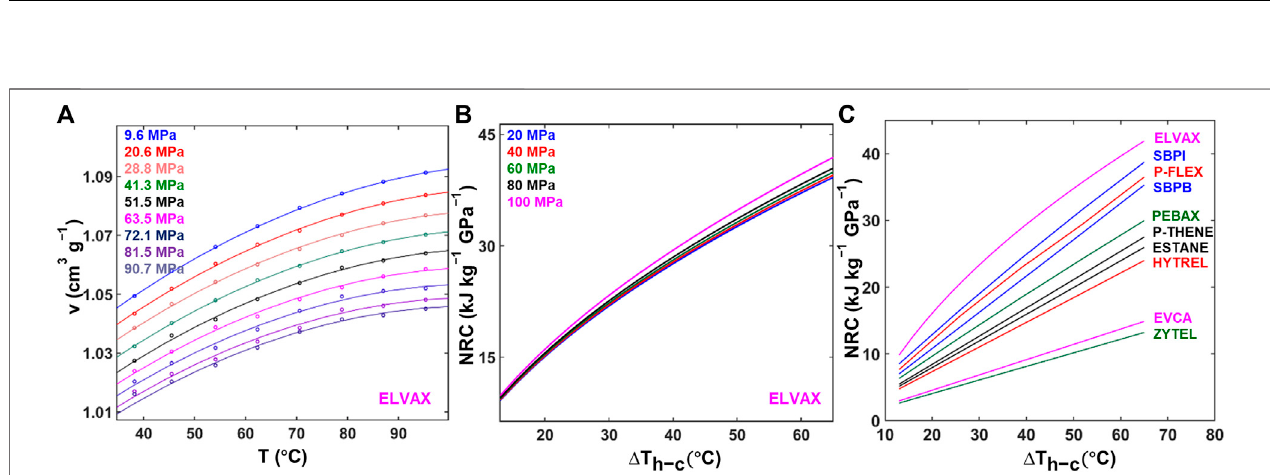
FIGURE 4 | Barocaloric property measurement. (A) pvT isobars shown for a representative material (ELVAX) (solid lines represent the Tait equation fi ts for each isobar). (B) Normalized refrigerant capacity (NRC) calculated for a cold reservoir temperature of 35 ° C and varying temperature spans ( Δ T h − c ) and pressures shown for ELVAX. (C) NRC as a function of Δ T h − c for all materials (measurement uncertainty < 0.3%) evaluated for Δ p = 100 MPa.